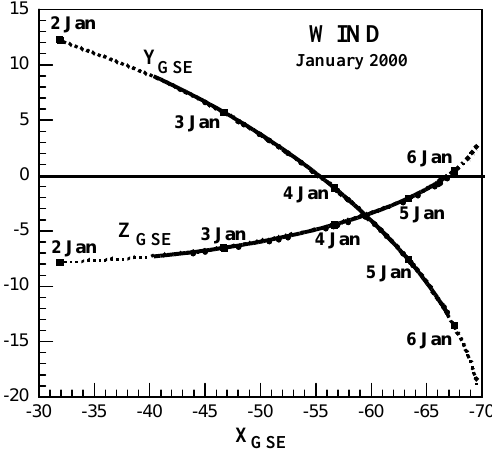
Fig. 9. The solid curves show the petal trajectory of the Wind space- craft in the magnetotail during an 80-hour period on 2–5 January 2000. The trajectory was very close to the boundary between the plasma sheet and the south